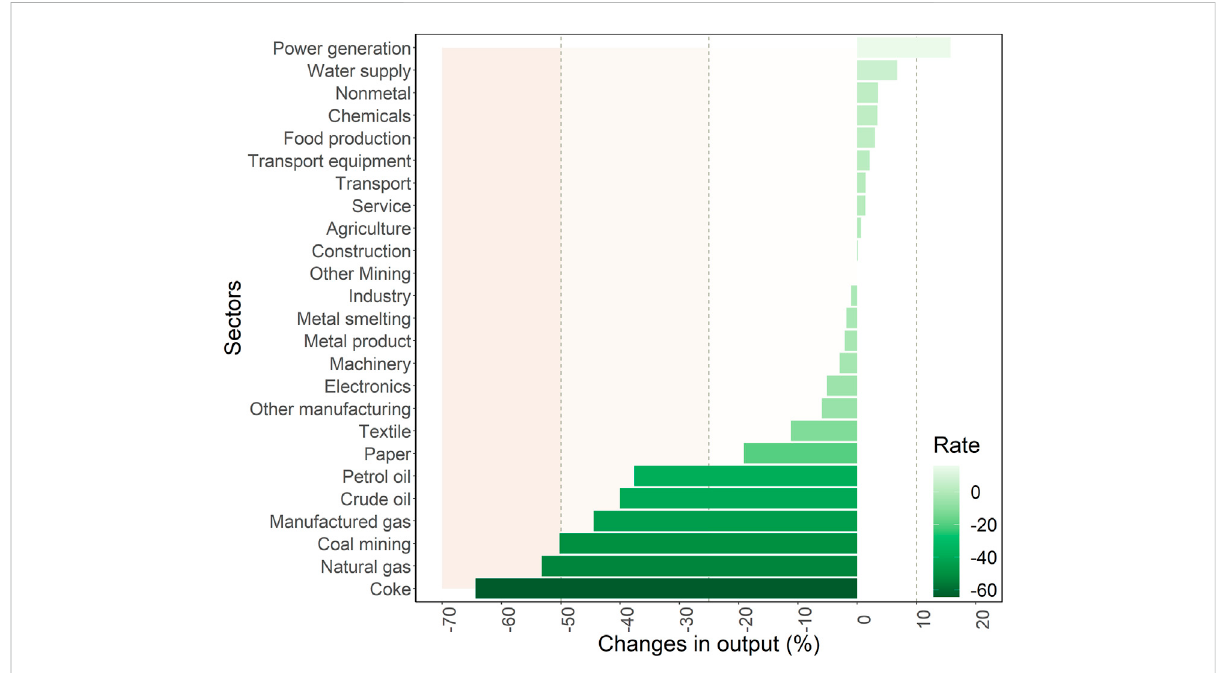
FIGURE 7 Output changes from the carbon neutral scenario to the baseline scenario in 2050 in